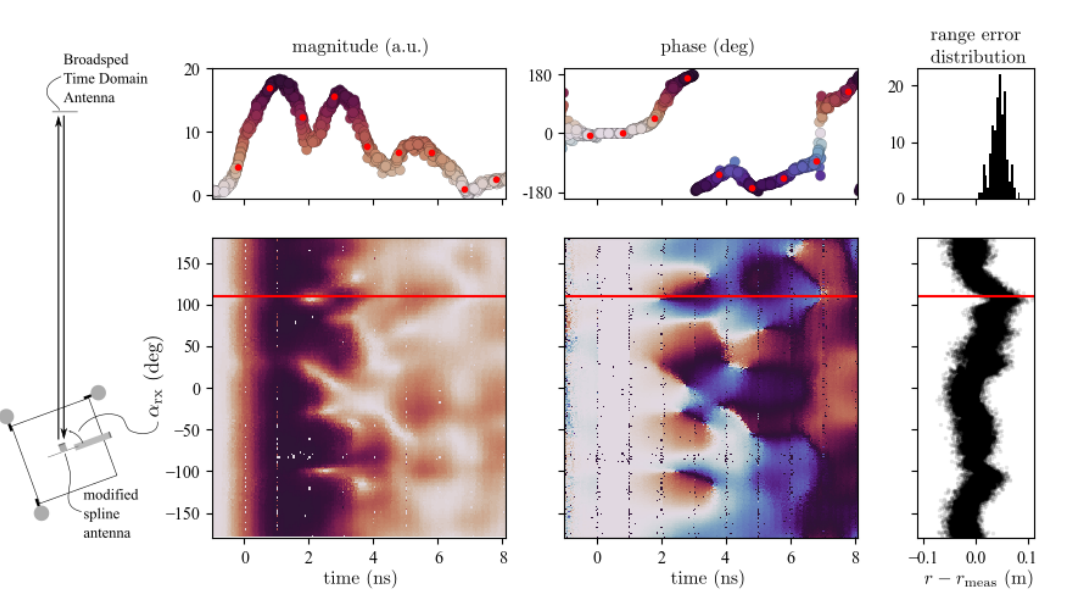
Figure 3. On the left, the experimental setup is shown with a modified spline antenna taking range and CIR envelope measurements for different AOAs to a Time Domain Broadspec antenna (pictures of both antennas are shown in Figure 2). The top plots show the magnitude and phase of over 100 accumulated and aligned CIR envelope measurements, and a histogram of the corresponding range error for an AOA of α rx = 110 ◦ . A single CIR envelope measurement is highlighted with red dots. The bottom plots show these metrics for all different AOA using the same color scheme as in the top plots whose AOA is marked with a red